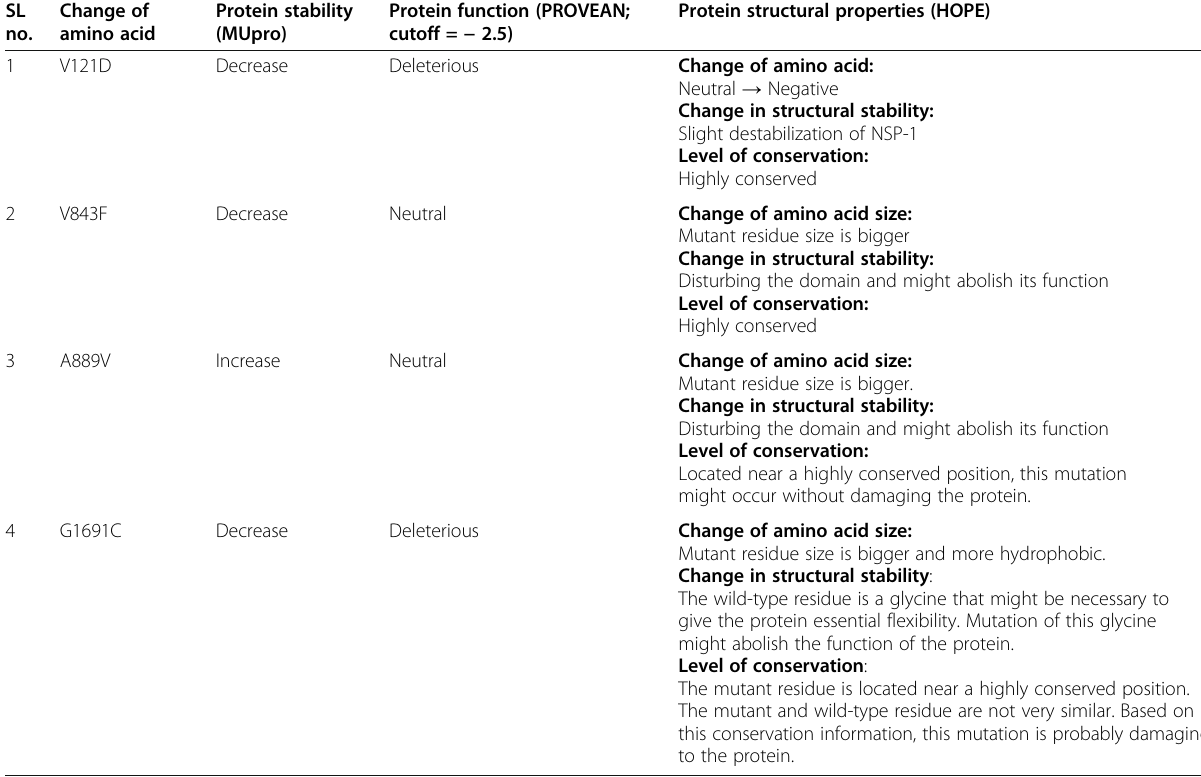
Table 2 Effect of the novel mutations in protein stability, function, and structure SL